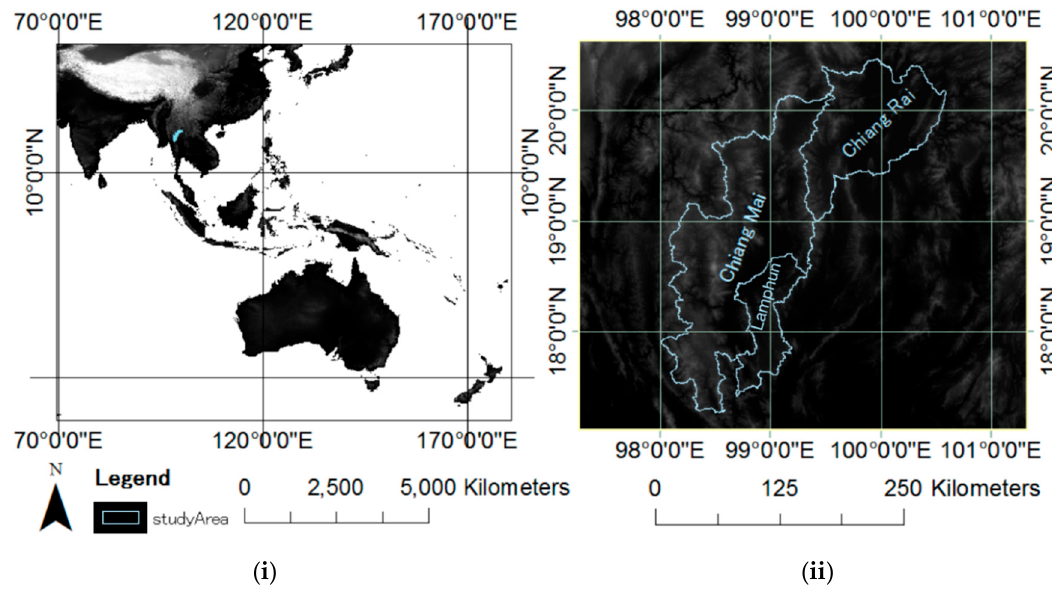
Figure 2. Digital elevation model (DEM) scenes for geomorphology classification: ( i ) AOI1 covers Asia–Oceania (resolution: 1000 m) and ( ii ) AOI2 covers Chiang Mai, Chiang Rai, and Lamphun. (resolution: 250 m).